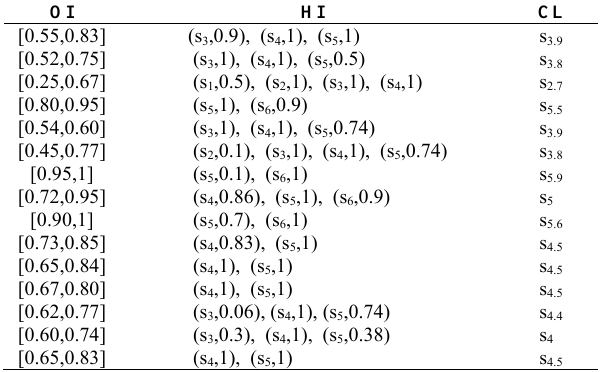
Table 4. Unified results of interval values.